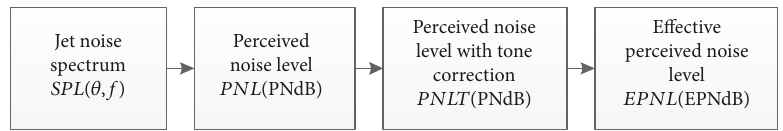
Figure 13: A simple procedure for estimating e ff ective perceived noise levels from the spectrum.